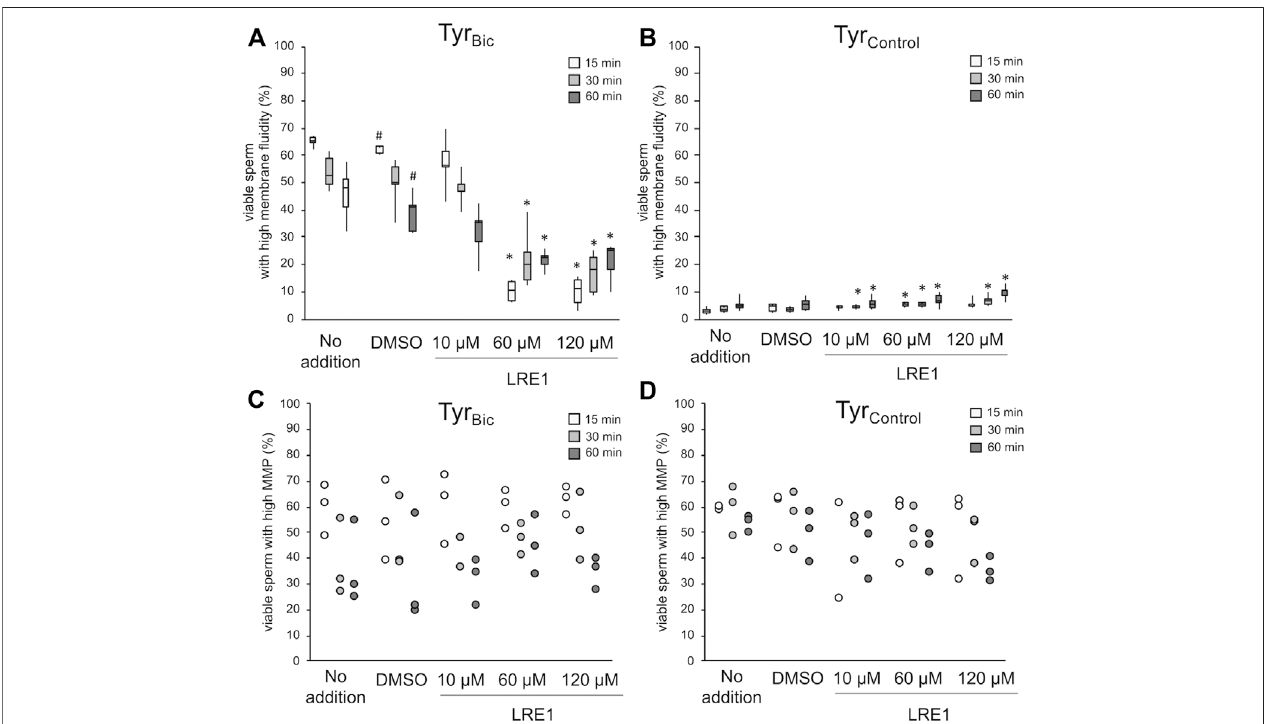
FIGURE 3 | LRE1 blocks sAC activity with no off-target effects on mitochondrial membrane potential. Spermatozoa were incubated either in presence of 30 mM bicarbonate (Tyr Bic ) or its absence (Tyr Control ). Media contained either no further additions, DMSO (solvent control), or an increasing concentration of LRE1 to directly block sAC activity. An increase in plasma membrane fl uidity, i.e., increased merocyanine 540 staining, in viable (Hoechst 33258 negative) sperm was monitored in absenceorpresenceofLRE1[ (A,B) ; n (cid:2) 6stallions].Ahashsymbol(#)indicatessigni fi cantdifferencesbetweenDMSOexposedsamplesandsampleswithoutany additions( p < 0.05). Anasterisk (*)indicates signi fi cant differences between DMSO exposed samples and samplestreated with LRE1 ( p < 0.05).In a subset ofsamples, the percentage of viable sperm with high mitochondrial transmembrane potential (MMP) was monitored using the probe JC-1 [ (C,D) ; n (cid:2) 3 stallions].